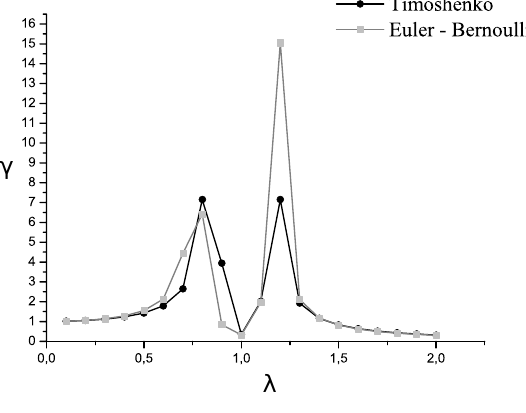
Fig. 6. Comparison between Timoshenko and Euler-Bernoulli